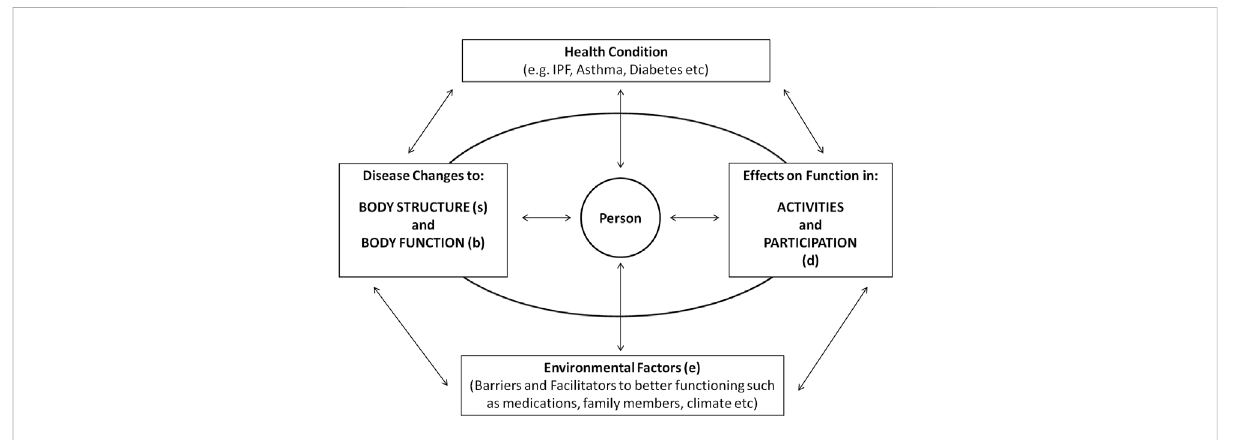
FIGURE 1 Interactions between domains of ICF in relation to the health condition. Courtesy of LA Saketkoo, with permission, rights